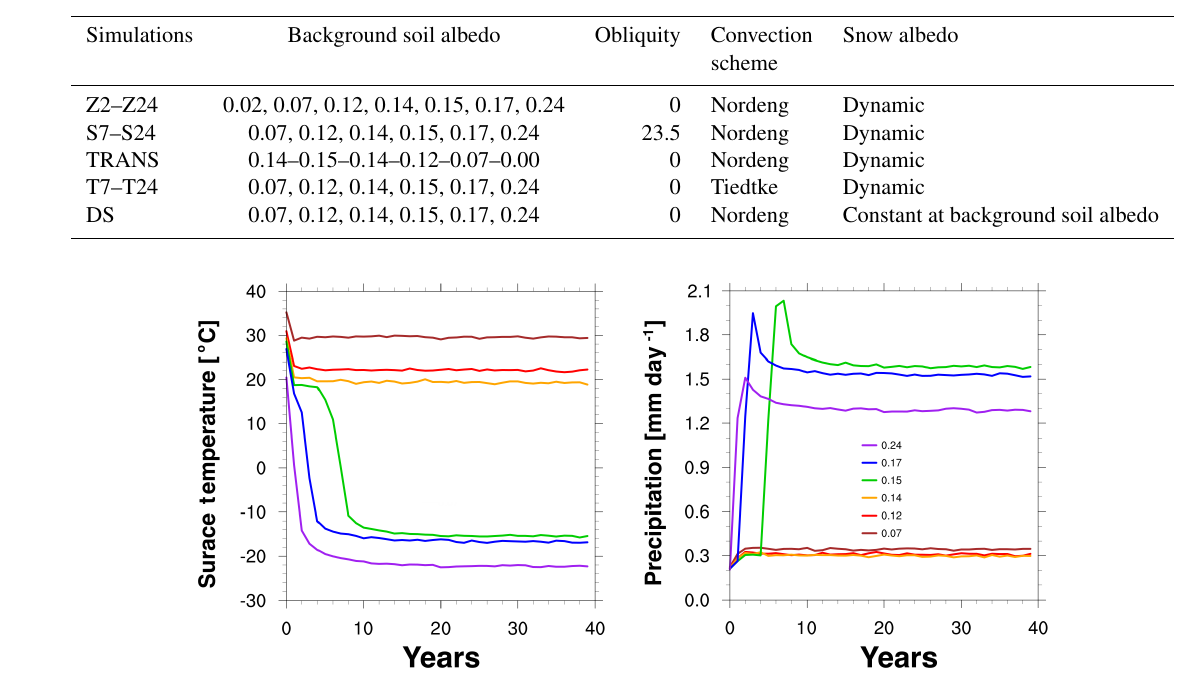
Figure 1. Time series of global mean surface temperature ( ◦ C) and precipitation (mmday − 1 ) for different background soil albedo values in the Z7–Z24